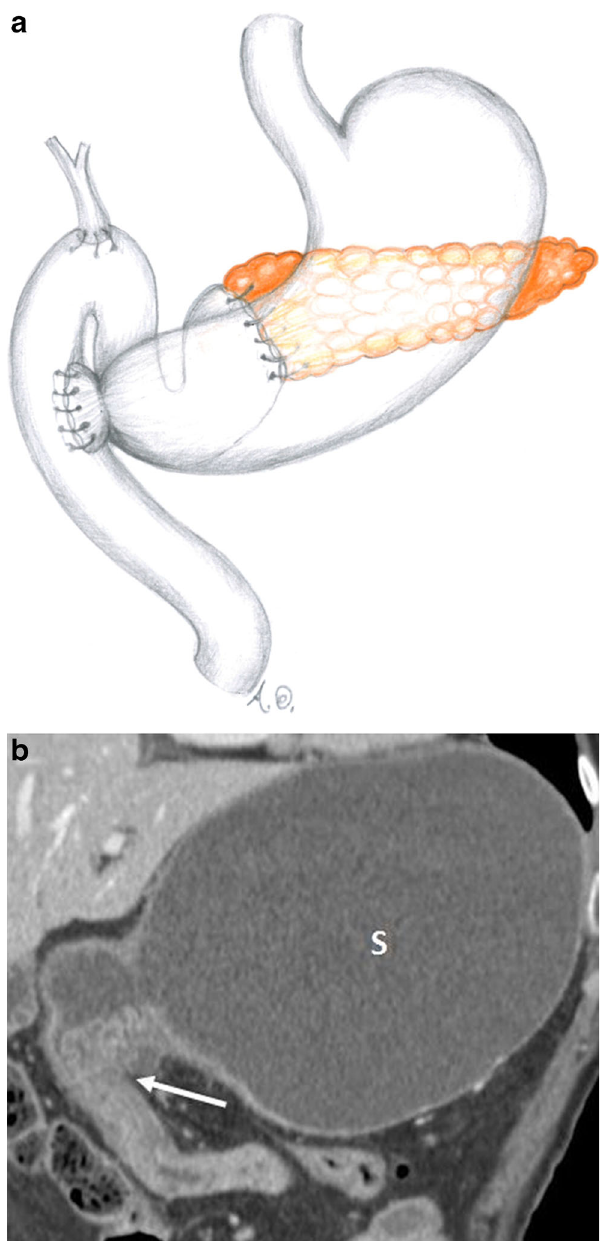
Fig.2 Pylorus-preservingpancreaticoduodenectomy( a , b ). a Drawing. b Coronal CT image. The duodenojejunostomy (white arrow) is visible. The stomach (s) is visualised